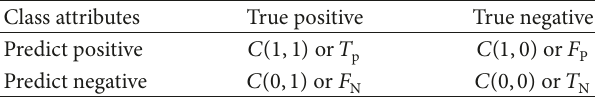
Table 1: The cost matrix of binary